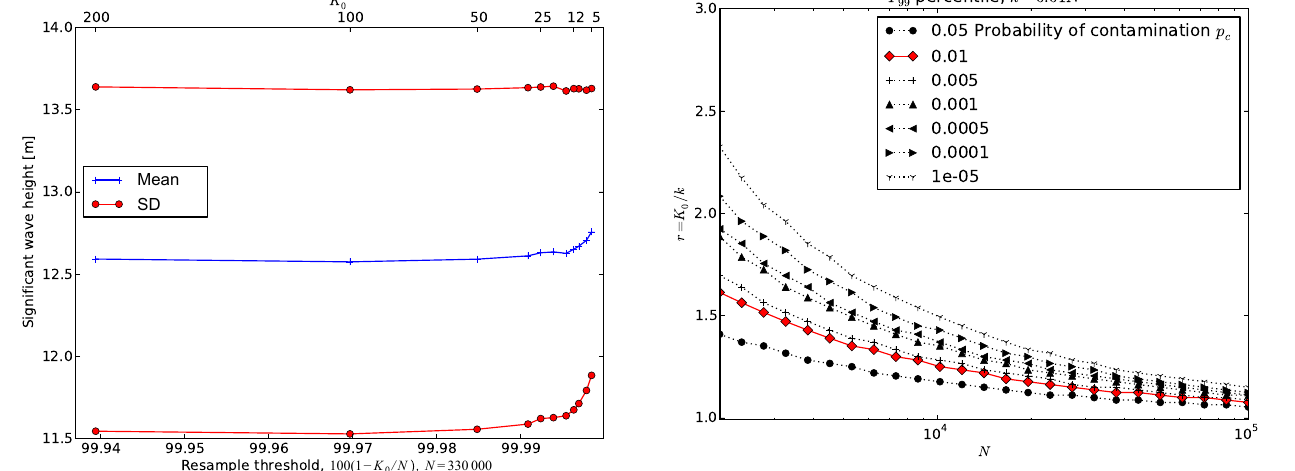
Figure 7. Bootstrapping the 99th percentile, P 99 . The ratio r = K 0 /k is shown as a function of sample size N . Here, the mini- mum number of entries required is simply the upper 1% ( P 99 ), so k = N/ 100. Various levels of probability of contamination p c are shown, and for sample sizes larger than approximately 2000, a ra- tio r = 2 is sufficient. The curve representing 1% probability of contamination is marked in red (with diamonds) as it represents a reasonable confidence